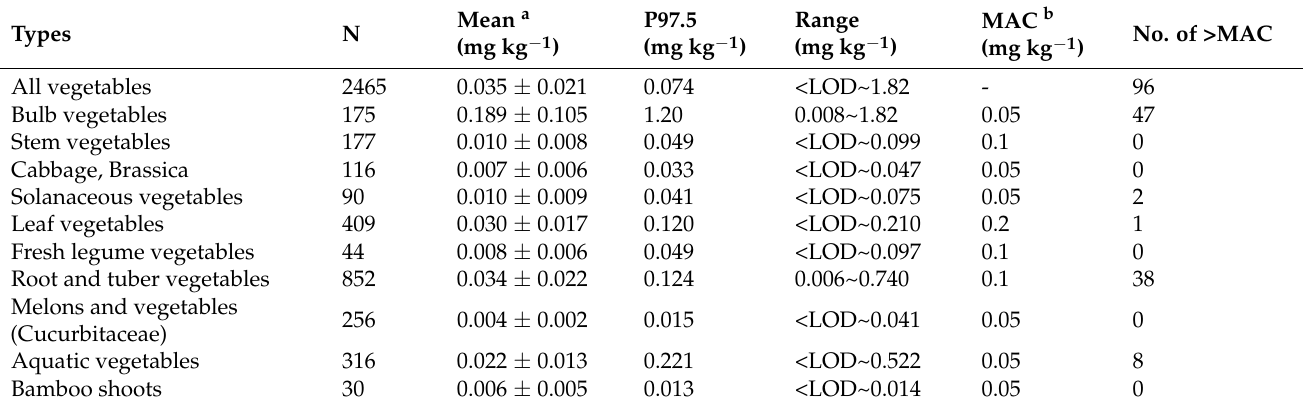
Table 1. The concentrations of Cd in vegetables (wet